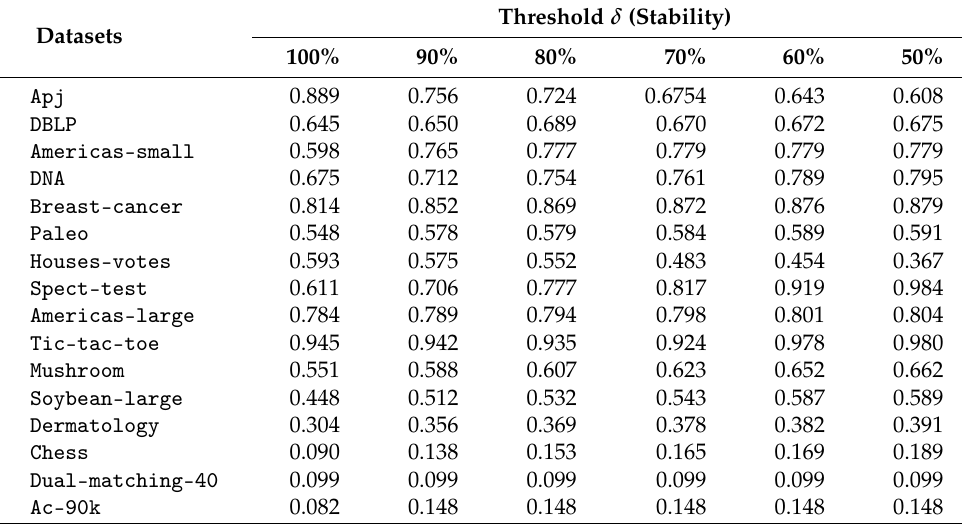
Table 10. The stability of the C ONCISE algorithm with different